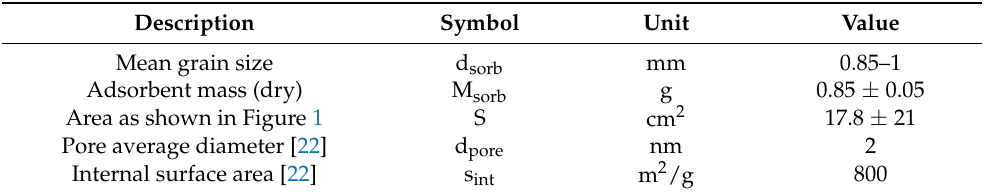
Table 2. Data of the loose grains configuration of Siogel (3_Sio).